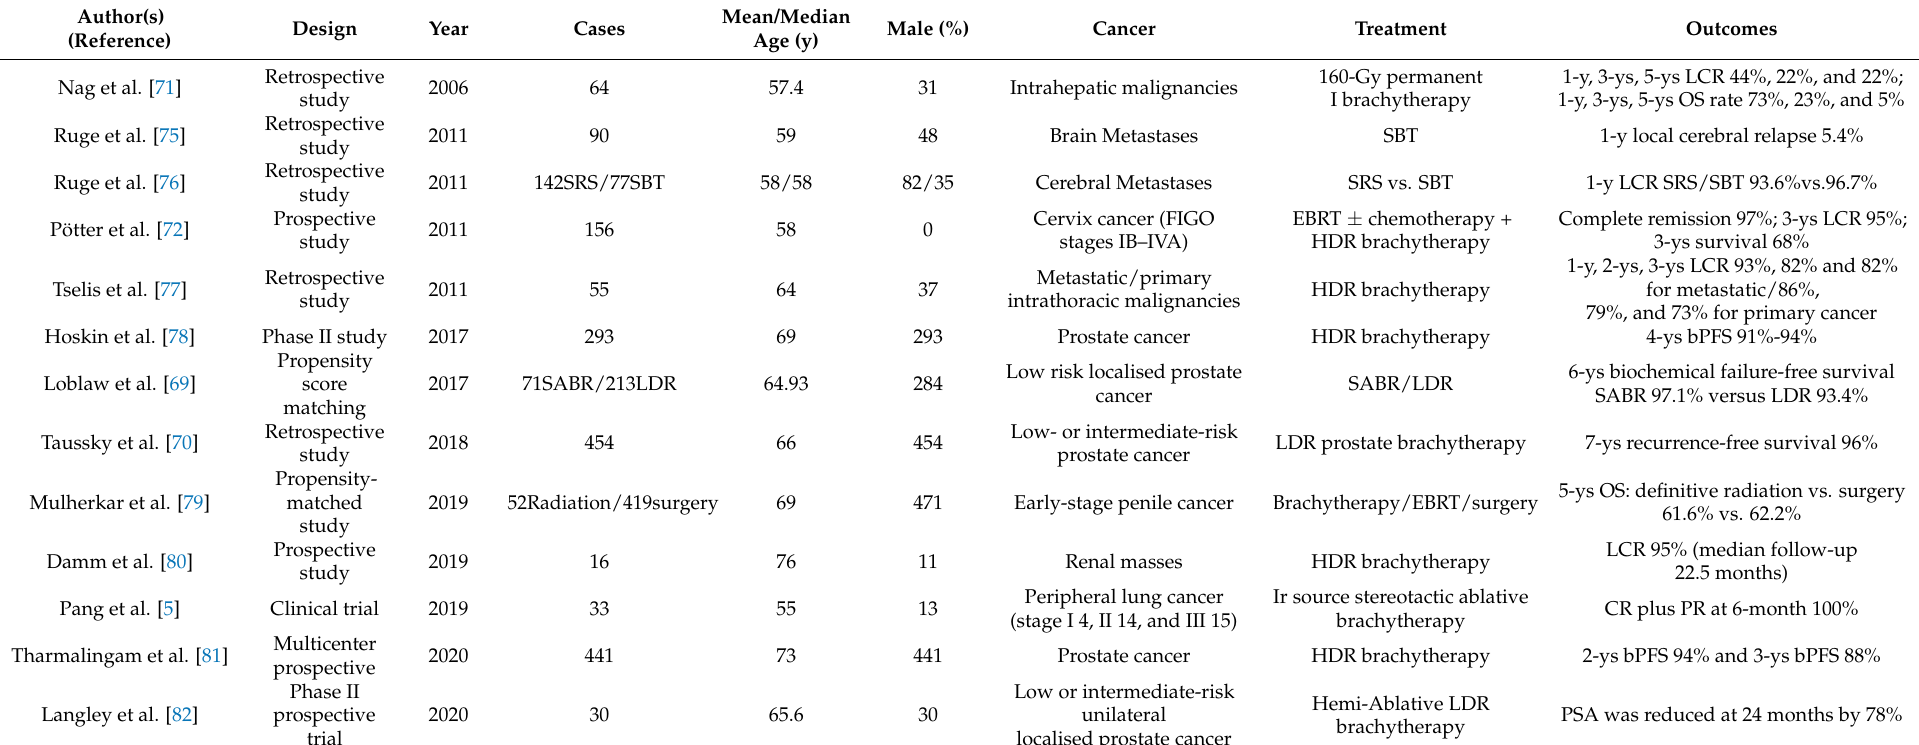
Table 1. Published literature involving ablative brachytherapy with reported local control/failure